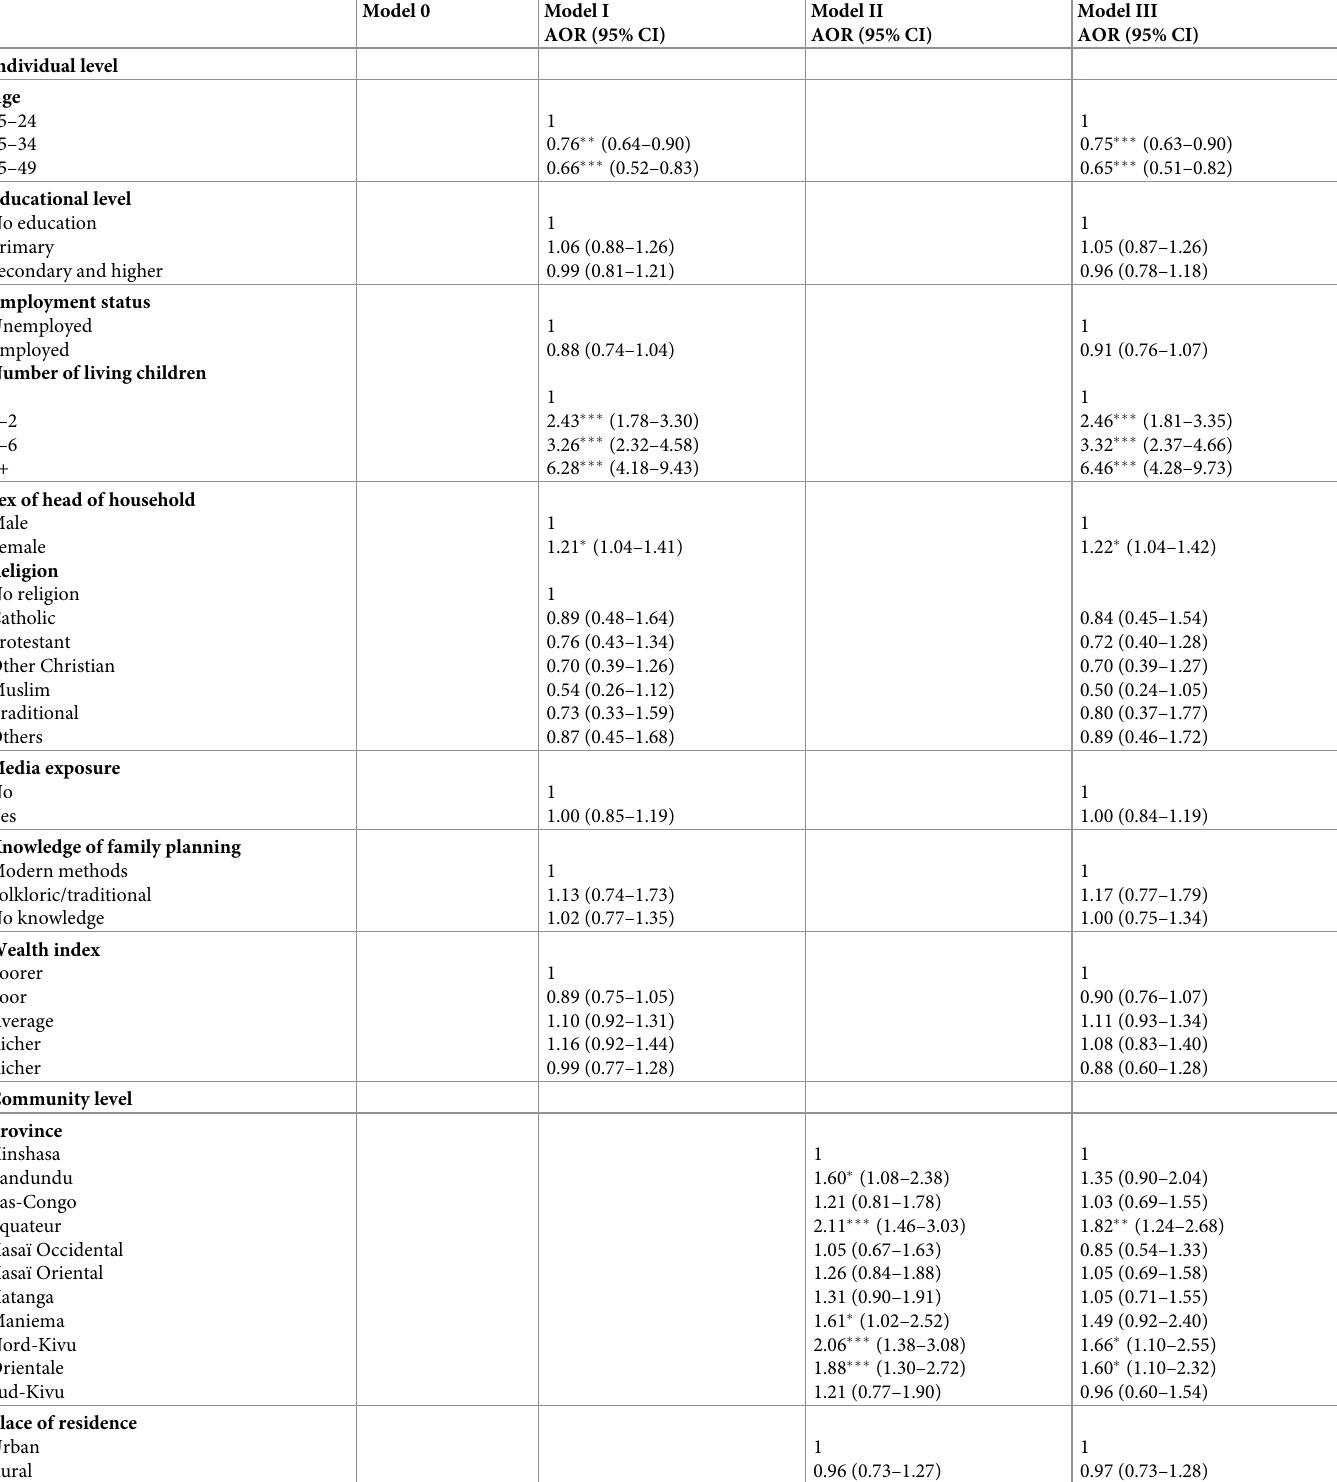
Table 2. Two-level logistic analysis of individual- and community level factors associated with total unmet need among married or in union